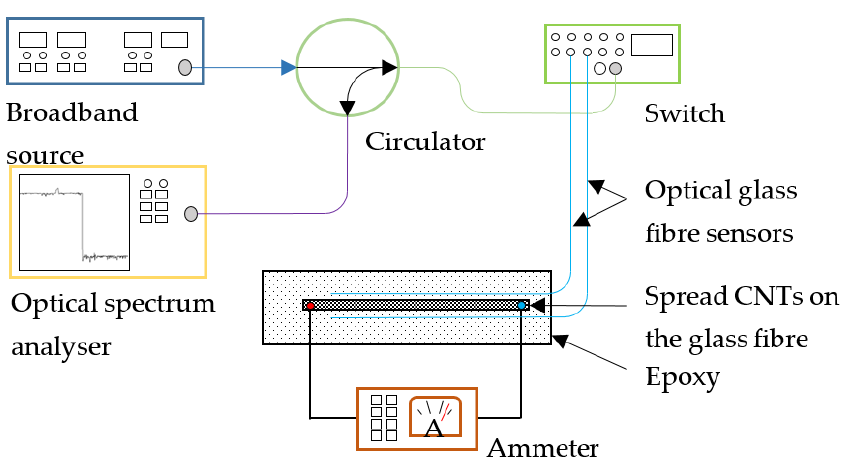
Figure 2. Schematic of the interrogation set up of the combined sensors GFRP sample.